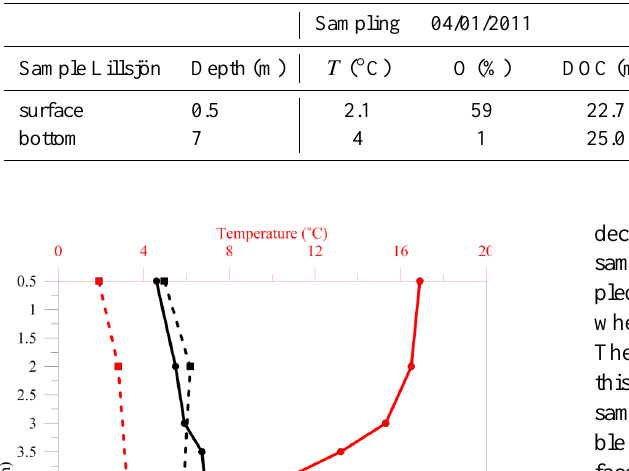
Table 1. Temperature, dissolved oxygen and DOC concentrations during sampling of Lillsjön, a boreal lake in 2011.